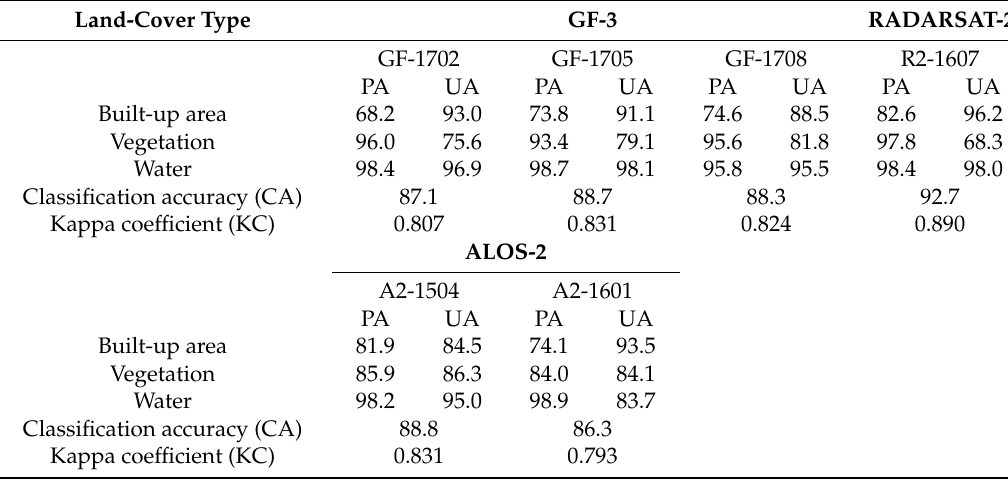
Table 5. Comparison of land-cover classification results in Wuhan using images from GF-3, ALOS-2, and RADARSAT-2